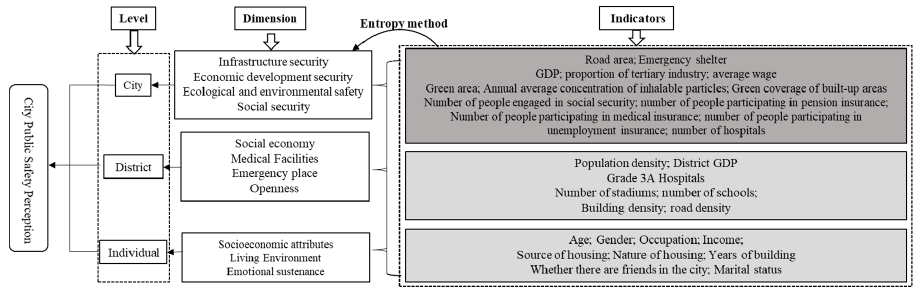
Figure 1. Indicator system framework of “city–district–individual”.